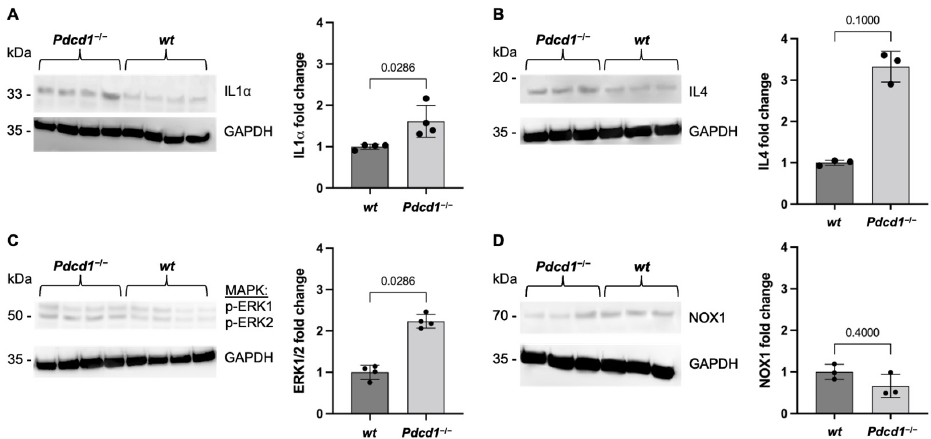
Figure 1. Elevated inflammatory cytokines in Pdcd1 − / − mice. Western blot analysis of whole heart homogenates from wt and Pdcd1 − / − mice showing ( A ) Interleukin 1 α (IL1 α ) ( n = 4 per group), ( B ) Interleukin 4 (IL4) ( n = 3 per group), ( C ) phosphorylated extracellular signal-related kinase 1/2 (p-ERK1/2) ( n = 4 per group), and ( D ) NADPH oxidase 1 (NOX1) expression ( n = 3 per group) in Pdcd1 − / − mice compared to wt mice. Black dots indicate individual samples.